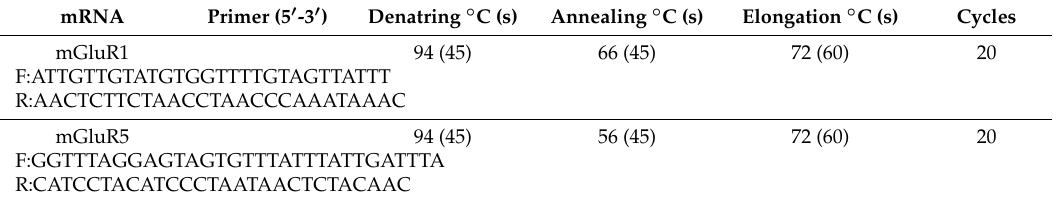
Table 2. Primer sequences and PRC conditions. All templates were initially denatured for 4 min at 98 ◦ C, and after completing all cycles, were extended a final extension of 8 min at 72 ◦ C. Primer (5 (cid:48) -3 (cid:48)